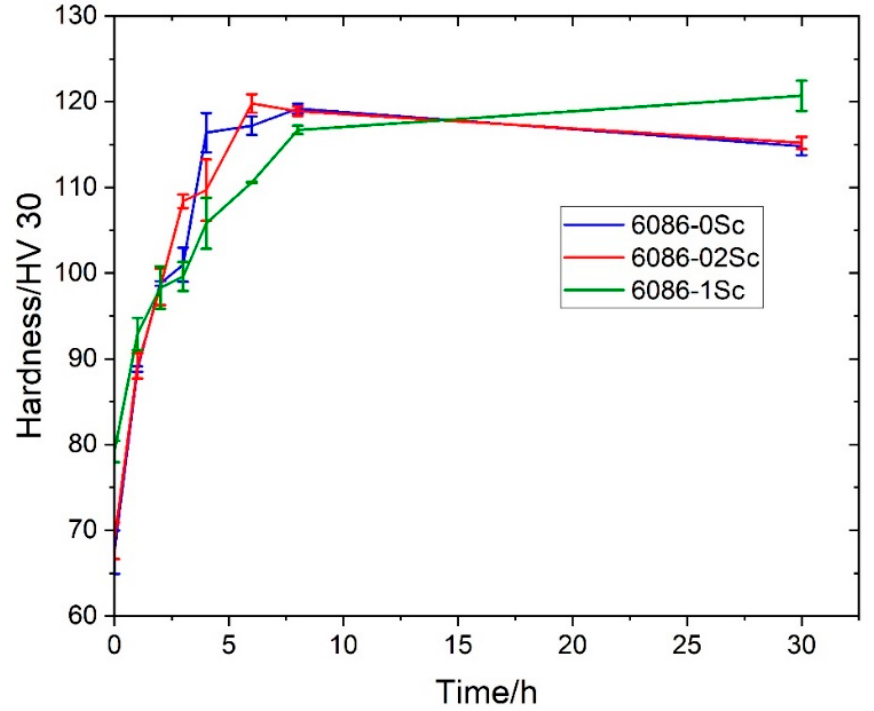
Figure 11. Evolution of Vickers hardness (HV 30) during artificial ageing at 180 °C for the alloys 6086-0Sc, 6086-0.2Sc, and 6086-1Sc. The starting condition is homogenised (solution treated) at 520 °C for 6 h and water quenched.